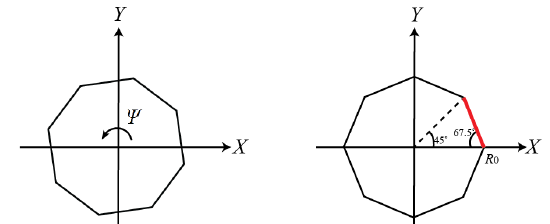
Figure 2. Rotation about the Z -axis with Ψ (2a, left); The nominal position and the trigonometric constraint in the first octant (2b, right) With the octagonal cone transformed to the nominal position, points lying on the octagonal side of the first octant (red in Figure 2b) satisfy the following trigonometric constraint